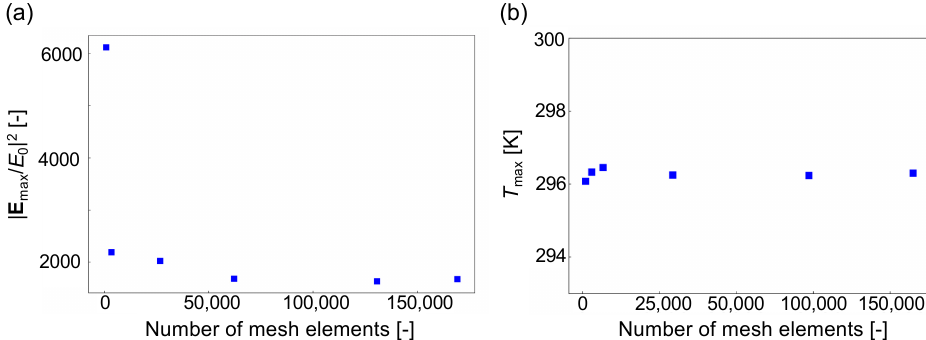
Figure A1. Mesh dependence of ( a ) maximum electric field enhancement and ( b ) maximum temperature.